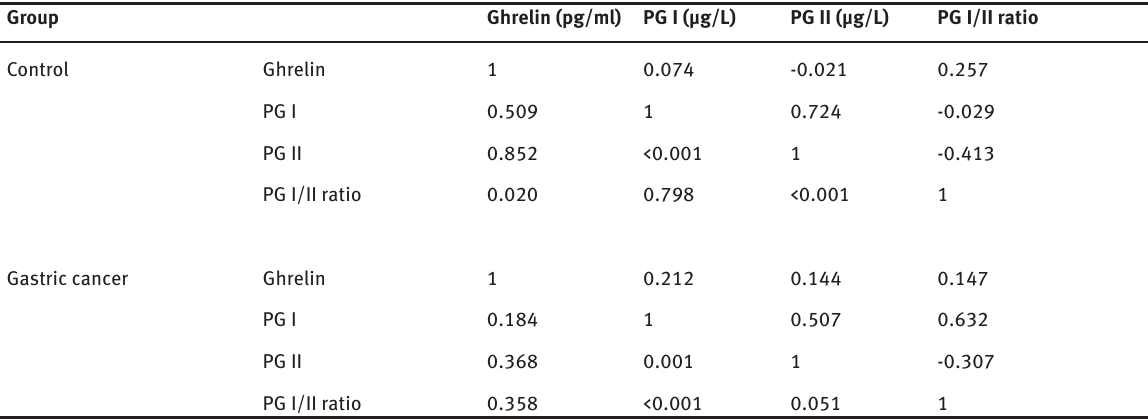
Table 3: Correlation analysis between plasma ghrelin levels and serum levels of pepsinogen I and II in control and gastric cancer group. In each group, upper diagonal: Pearson coefficient; lower diagonal: P value.